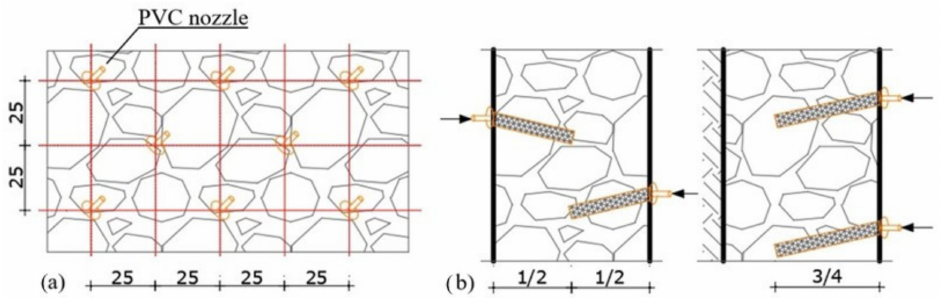
Figure 8. Natural hydraulic lime-based (NHL 5 mortar) grouting: ( a ) Insertion of the PVC nozzles (dimensions in cm), ( b ) Grouting depth compared to the width of the